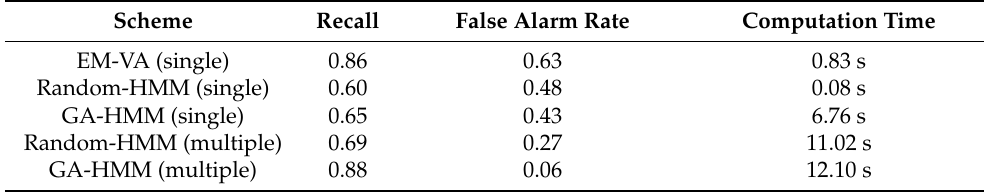
Table 1. Recall, false alarm rates, and computation time of the investigated